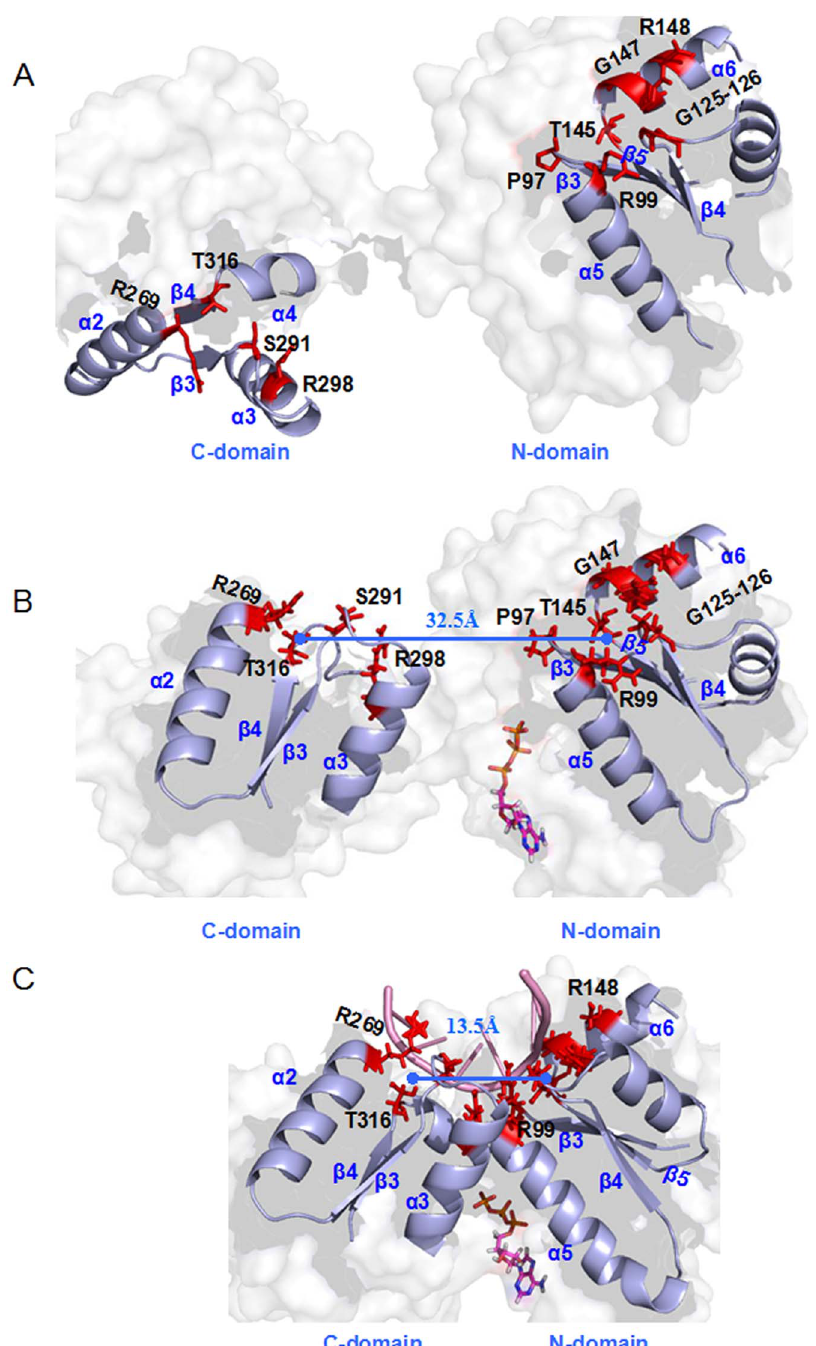
Figure 9. The distances of RNA binding sites in the eIF4A protein. The residues (red sticks) at the RNA binding region ( a helices and b strands) in (A) the O-eIF4A, (B) ATP + eIF4A and (C) ATP + RNA + C-eIF4A models with the mass center distances of RNA binding sites at the two domains (light blue line). doi:10.1371/journal.pone.0086104.g009 from 38.1 A ˚ in the RNA + eIF4A/I’ model, 35.5 A ˚ in the II’ model, 32.5 A ˚ in the III’ model, to 29.8 A ˚ in the IV’/ ATP + RNA + C-eIF4A model to form the final closed state. The cooperative occurrence of such relative rotation and proximity of the two domains induced by ATP and RNA binding to the eIF4A protein suggests that the cooperative mediation of ATP and RNA plays a key role in the structural transition of eIF4A protein from